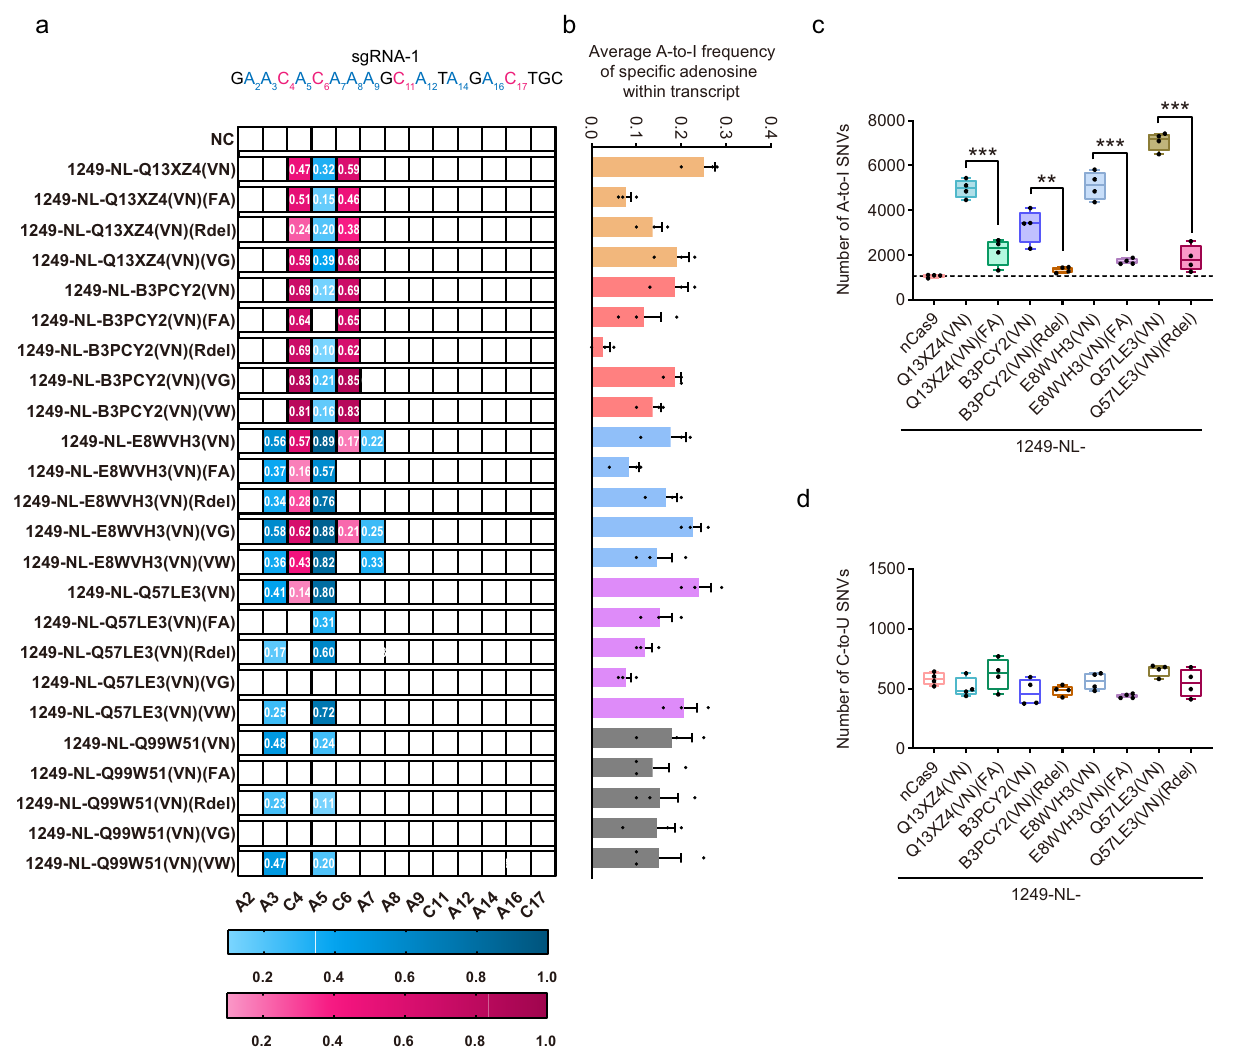
Fig. 4 | Minimization of RNA off-target effects for TadA ortholog-derived base editors.a , b DeaminasemutagenesisscreeningtominimizeRNAoff-targeteditsof representative TadA ortholog-derived base editors. Heatmap format showing the on-target editing activity at sgRNA-1, with adenine editing activity in blue and cytosine editing activity in pink ( a ) and histogram showing RNA A-to-I conversion frequency at a speci fi c site within mRNA transcript ( b ). NC, negative control. VN, FA, Rdel, VG, and VW, amino acid substitutions corresponding to A106V&D108N, F148A, R153 deletion, or V82G/W of ecTadA, respectively. RNA A-to-I conversion frequency of base editors containing Q13XZ4, B3PCY2, E8WVH3, Q57LE3, and Q9951 were depicted in orange, pink, blue, purple, and gray, respectively. Data